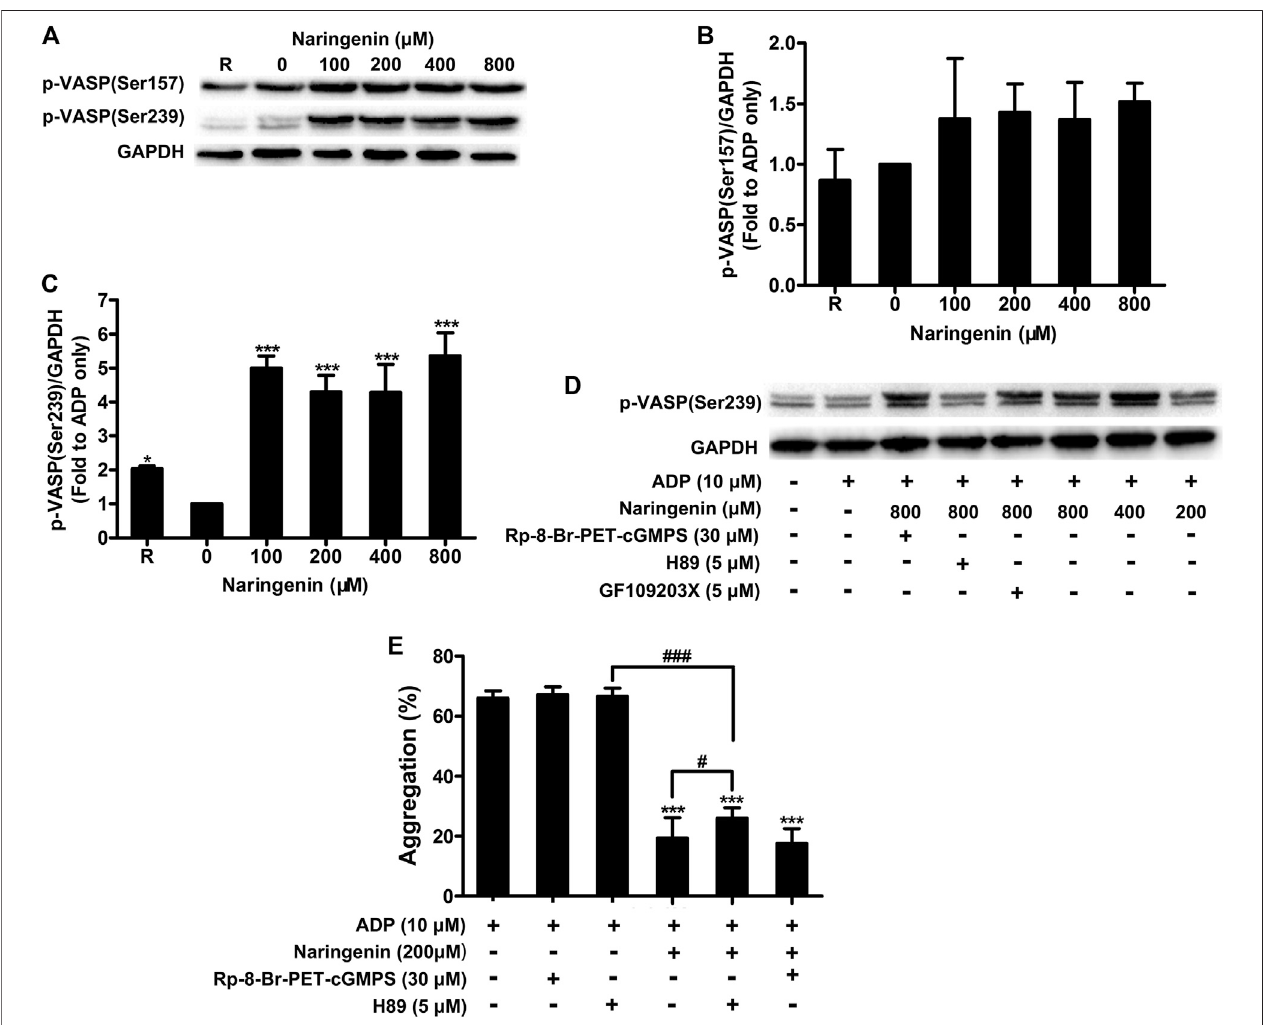
FIGURE 7| Naringenin promotes VASP phosphorylation. The effects ofnaringenin on phosphorylation ofVASP (at positions Ser 157 and Ser239) were measured in washed platelets upon stimulation with ADP (10 μ mol/L) by western blotting (A) . The blots shown are representative of three separate experiments. The phosphorylation levels were quanti fi ed by ImageJ 1.47v software. The level of phosphorylation obtained with vehicle control (0 μ M) was taken as 1 (B,C) . R represents the phosphorylation level in resting platelets. Data are expressed as means ± SD ( n (cid:2) 3). * p < 0.05, *** p < 0.001 compared with the vehicle control group. VASP phosphorylation at Ser239 was also analyzed in washed platelets incubated with 5 μ mol/L PKA (H89), 30 μ mol/L PKG (Rp-8-Br-PET-cGMPS), or 5 μ mol/L PKC (GF109203X) inhibitors before treatment with naringenin (D) . Washed platelets were incubated with vehicle or naringenin (200 μ mol/L) at 37 ° C in the presence or absence of 5 μ mol/L PKA (H89) or 30 μ mol/L PKG (Rp-8-Br-PET-cGMPS) inhibitors. After treatment, platelets were stimulated with ADP (10 μ mol/L) to trigger aggregation (E) .Dataareexpressedasmeans ± SD( n (cid:2) 6).*** p < 0.001comparedwiththeADP-treatedgroup, # p < 0.05, ### p < 0.001comparedwithnaringeninalone or H89